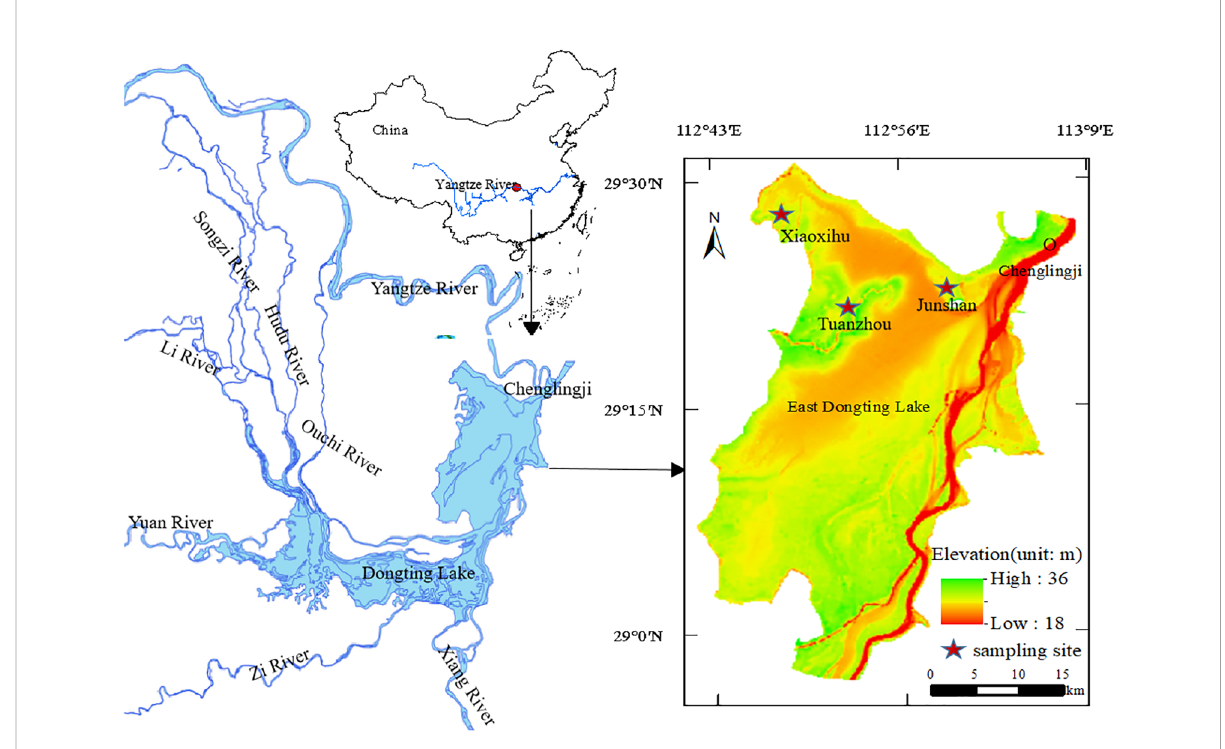
FIGURE 1 Study area and sampling site locations at East Dongting Lake,